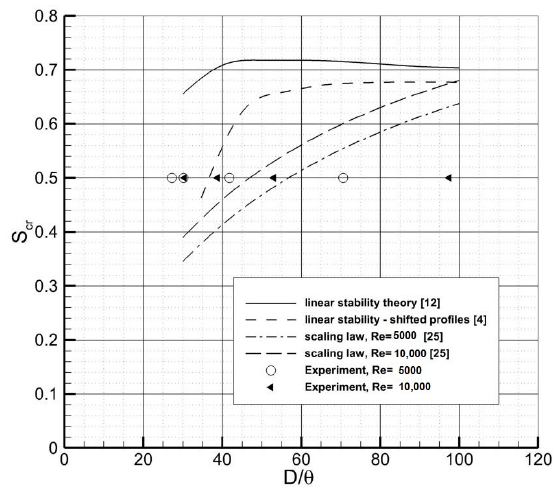
Figure 6. Convective/absolute/global boundary. Linear stability theory results of Jendoubi and Strykowski [19] and Boguslawski et al. [18] compared with a universal scaling law of onset into the global mode proposed by Zhu et al.